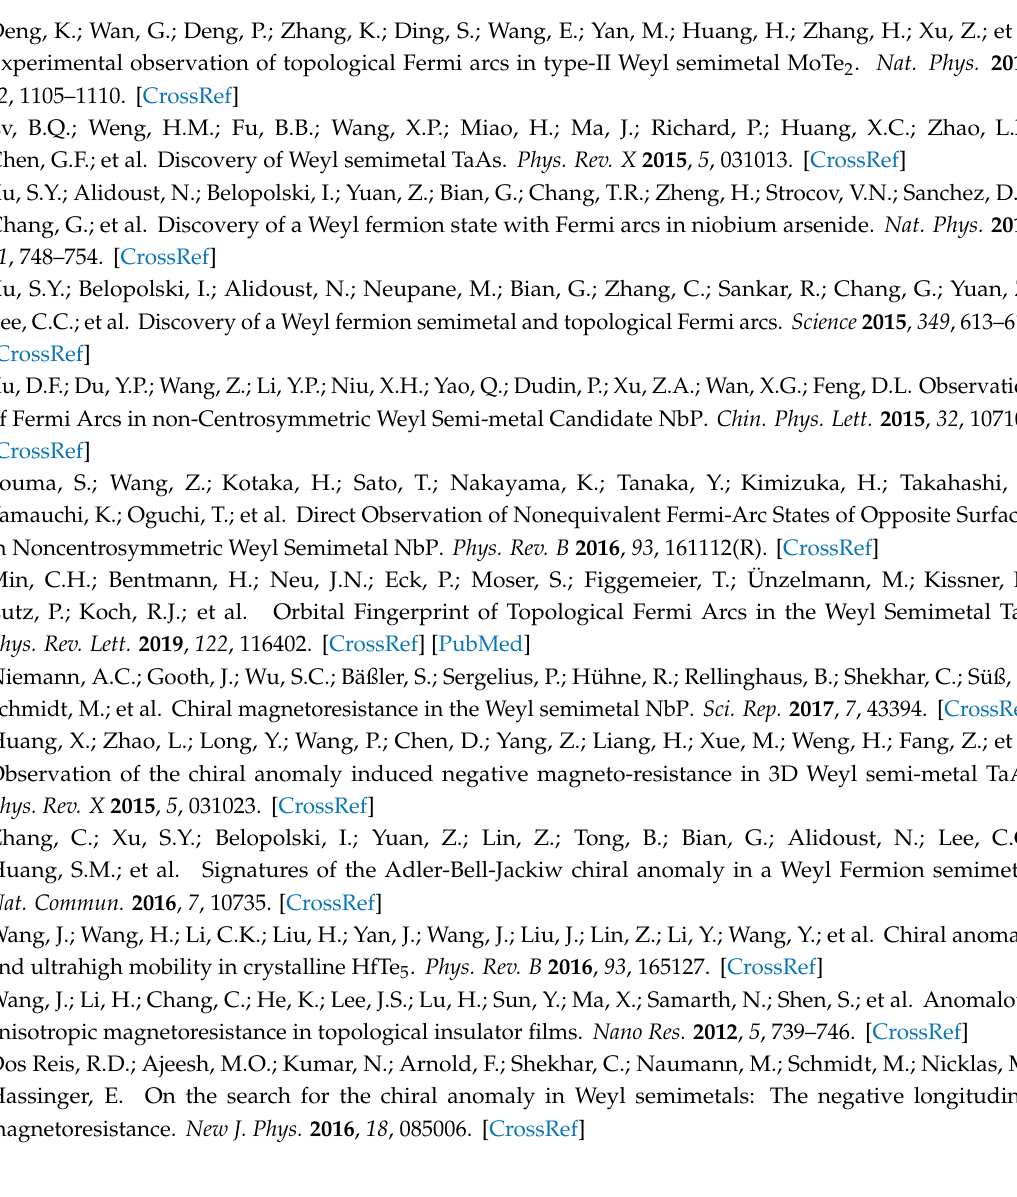
Figure S1: Temperature and field sweeps of all crystals. Figure S2: Illustration of characteristic field identification. Figure S3: Angle dependence of characteristic fields with different fittings. Figure S4: IV curves and dV / dI of sample 4. Figure S5: IV curves and dV / dI of sample 4, highlighting the low-current region. Figure S6: Quantum oscillation data of sample 4. Figure S7: Magnetoresistance data of sample 1. Figure S8: Powder XRD spectrum of the parent